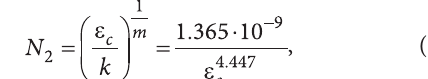
Table 6. Values of the correlation coefficient between sets of a fatigue life data calculated for considered configurations